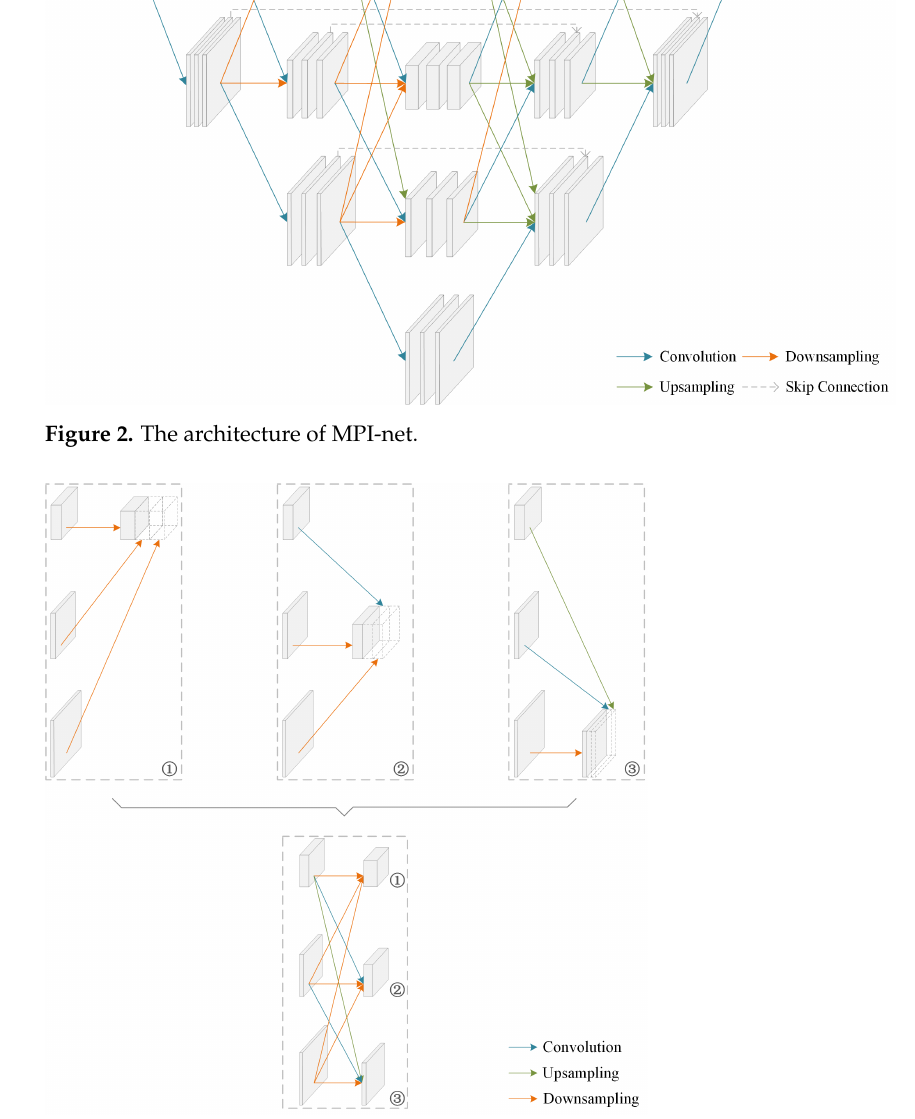
Figure 3. Illustrating how the exchange unit aggregates the information for different paths. Feature maps from different paths are transformed to the same resolution and then